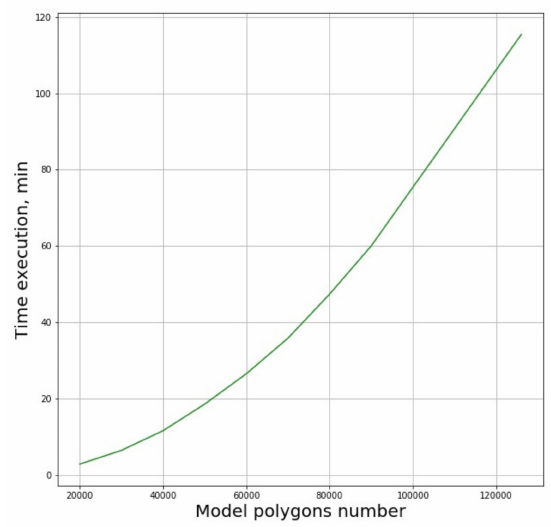
Figure 7. Performance as a function of polygon number in the 3D